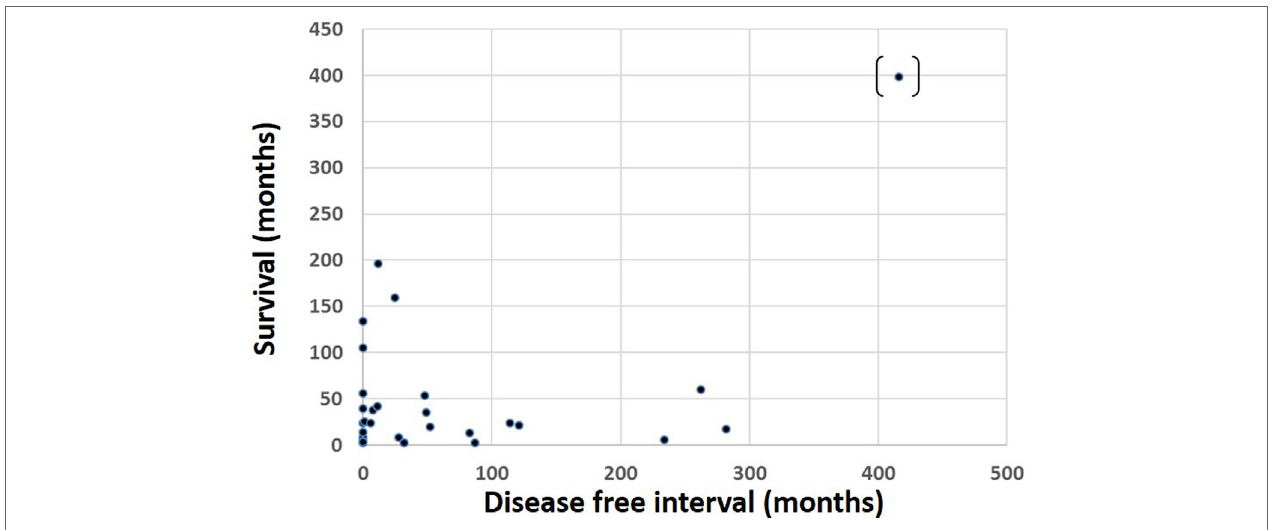
FigUre 4 | Survival time after presentation with orbital disease in 69 patients, as related to the interval between primary tumor diagnosis and orbital